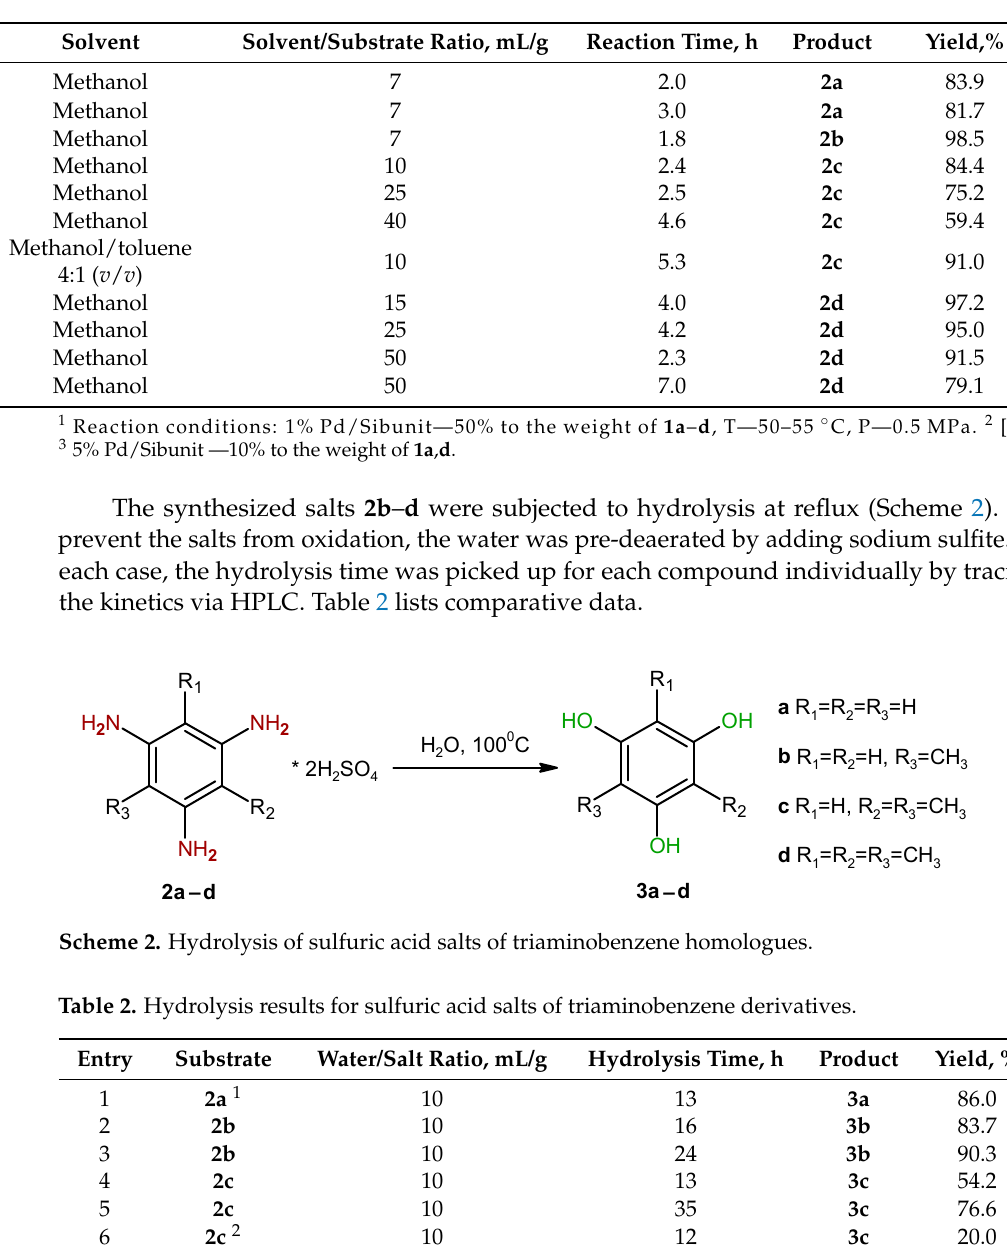
Table 1. Hydrogenation of methyl derivatives of trinitrobenzene in methanol 1 . .